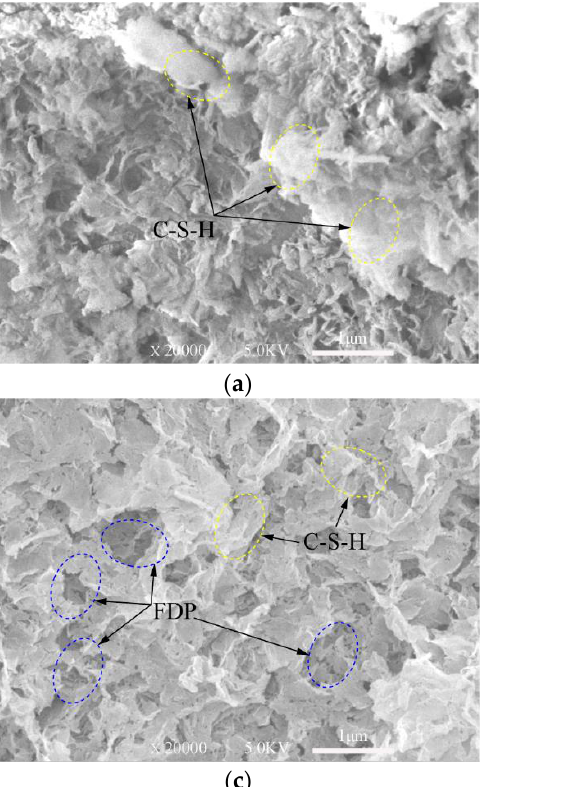
Figure 8. SEM images of 7-day samples under different freeze–thaw cycles. ( a ) Unfrozen; ( b ) After